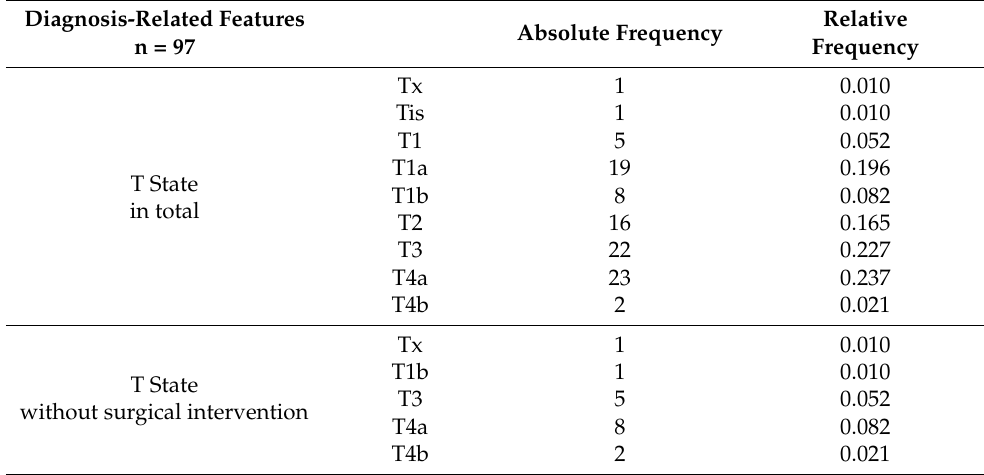
Table 2. Statistical description of the diagnosis-related factors for therapy